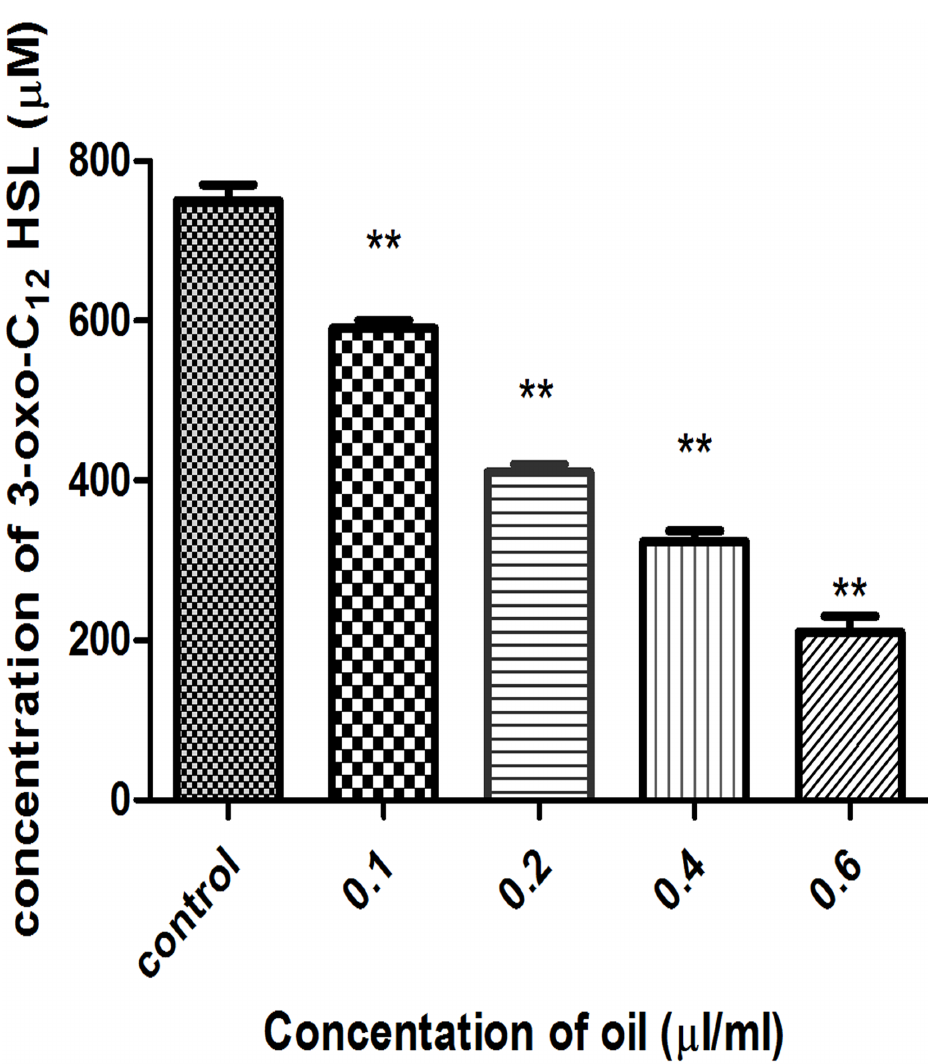
Fig 3. Effects of different concentrations of cinnamon oil (control, 0.1, 0.2, 0.4, 0.6 μ l/ml) on the concentration of 3-oxo-C 12 HSL produced by P . aeruginosa PAO1grown up to